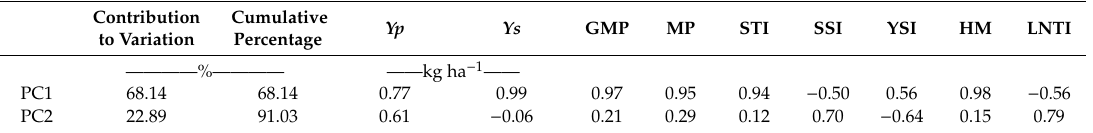
Table 3. Results of principal component analysis for grain yield under HN ( Yp ) and LN ( Ys ) and seven screening index values for 31 inbred lines.